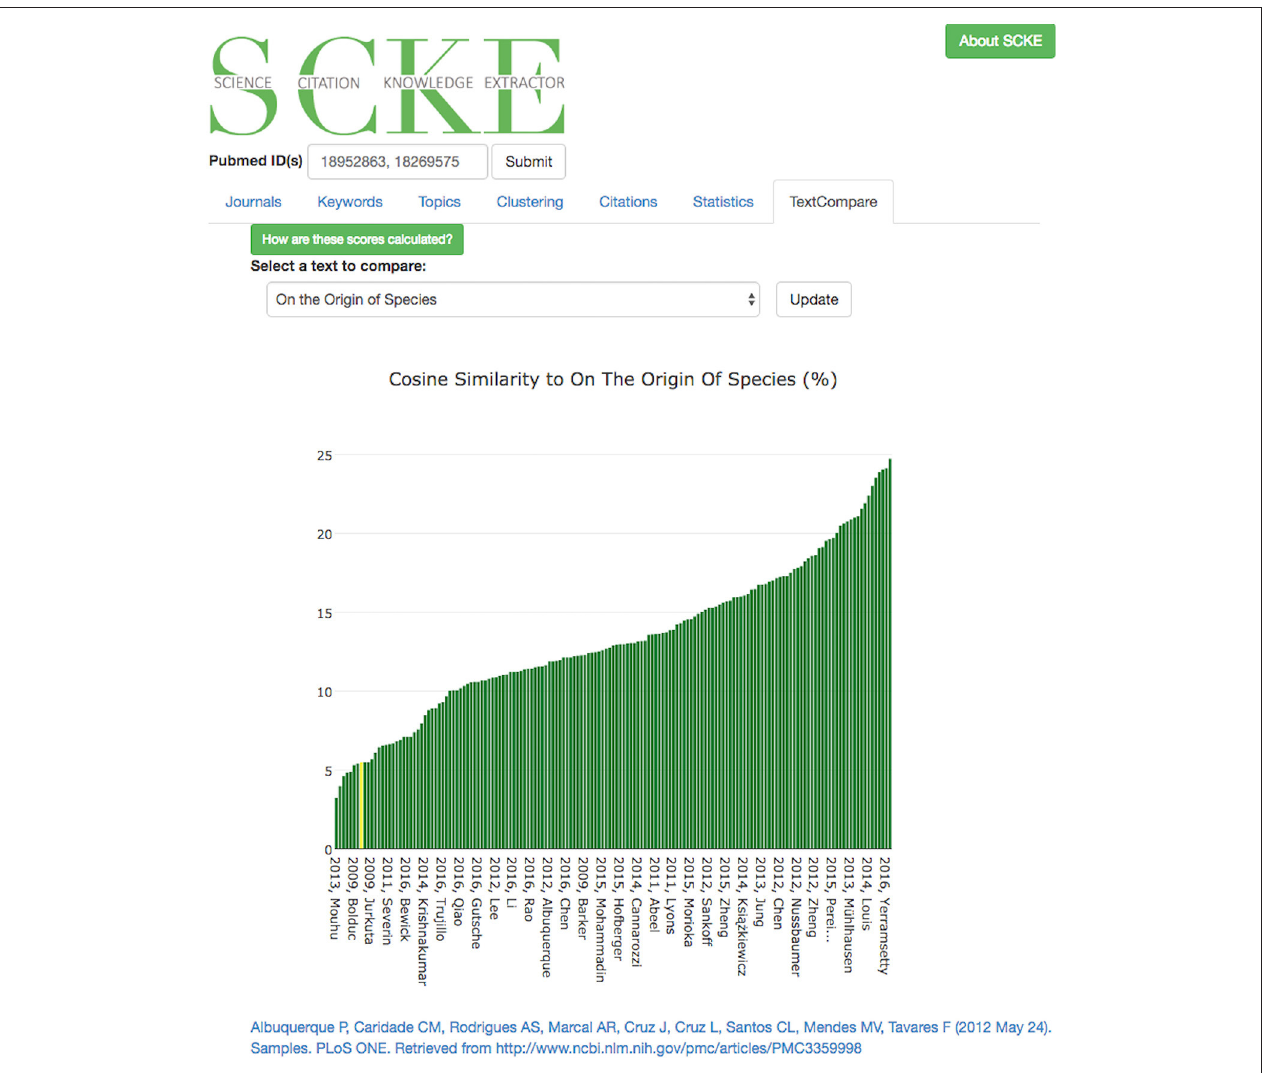
FIGURE 10 | Results of TextCompare are displayed in an interactive bar chart, where the height of the bar corresponds with the percent similarity of that document to the text its being compared to (here, “On the Origin of the Species”). If the text for the query documents used by SCKE were available, they will be shown in yellow. In this bar chart, we see that computational genetics paper are much less similar to “On the Origin of the Species” than other wet lab genetics papers that cited the input